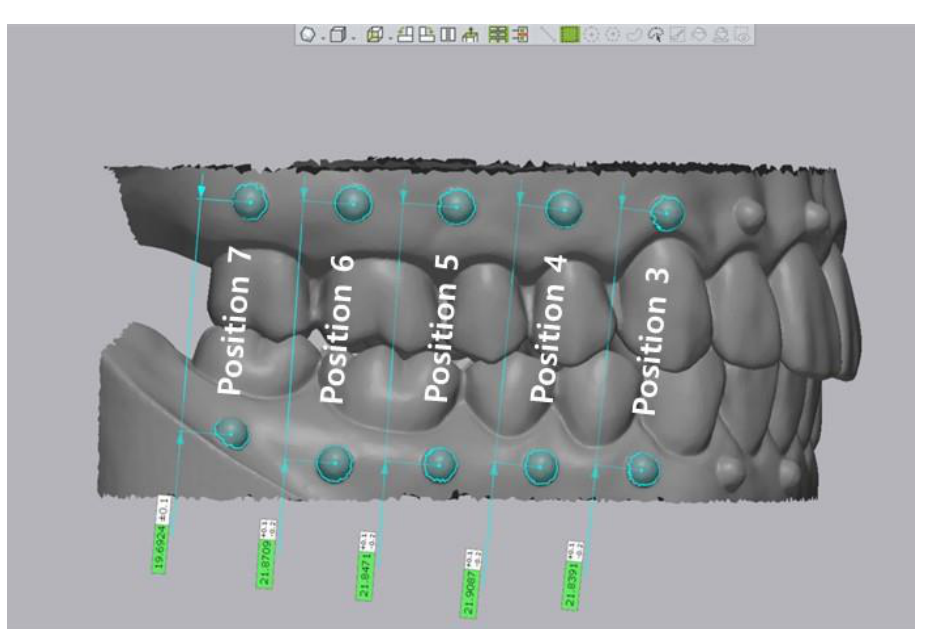
Figure 3. Measuring the linear distance of the interarch marker using the surface matching software.